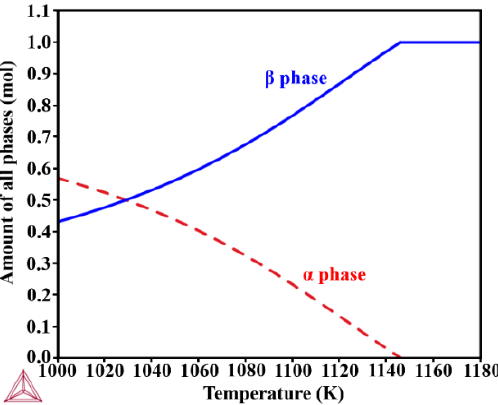
Figure 3. Calculated equilibrium phase fractions of Ti-17 alloy from 1000 to 1180 K.